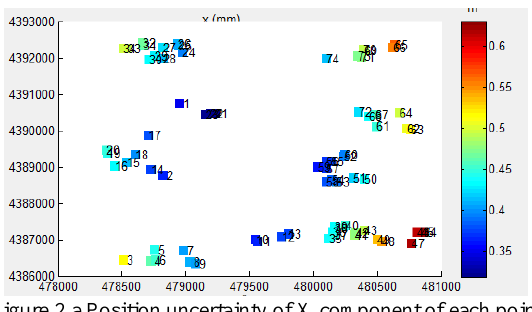
Figure 4.b Distribution of uncertainty for Z component for whole stereo model